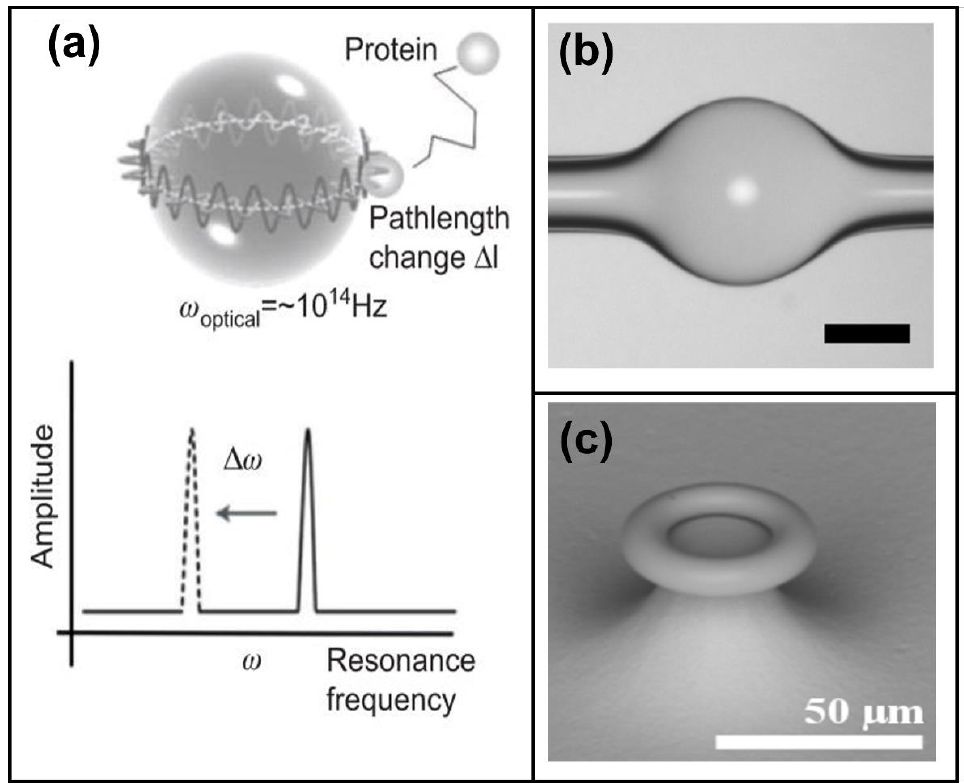
Figure 4. ( a ) Illustration of an optical resonance in a glass microsphere. The binding of a protein to the microsphere surface increases the whispering gallery m ode (WGM) path length by Δl, produc- ing a resonance frequency shift Δω. ( b ) Optical image of the microbubble resonator and ( c ) scanning electron micrograph (SEM) of as-fabricated microtoroid. ( a ) Reprinted with permission from [66], copyright 2012, De Gruyter. ( b ) Reprinted with permission from [75], copyright 2022, PNAS. ( c ) Reprinted with permission from [76], copyright 2010,